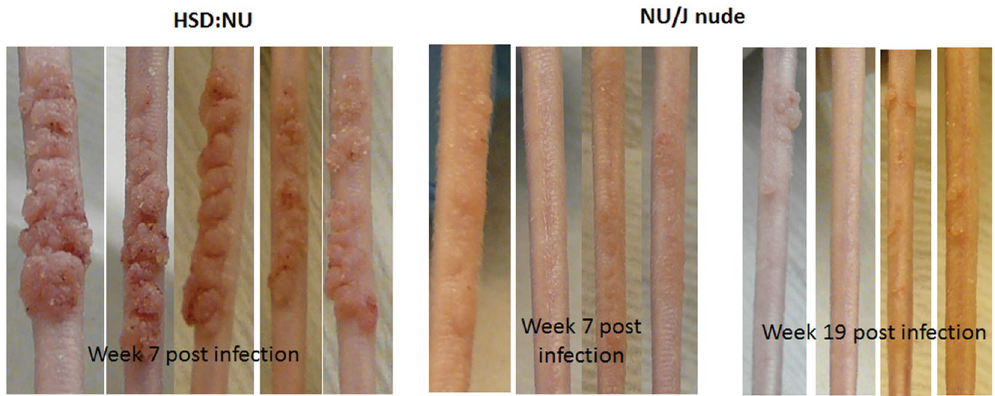
Figure 2. Tail infections in athymic HSD: NU mice were more vigorous than those in athymic NU/J mice. Hsd: NU (N = 5) and NU/J (N = 4) mice were infected on the tails with MmuPV1. Lesions became visible around week two post-infection in both mouse strains. However, lesions on Hsd: NU mice (Left) persisted and became significantly larger than those on NU/J nude mice by week seven post-infection (Right). The lesions on NU/J nude mice remained small and did not grow to significant size by week nineteen post-infection. One of the four NU/J nude mice did not develop any lesion at the tail site. Similar results were found at the muzzle sites in these two immunodeficient mouse